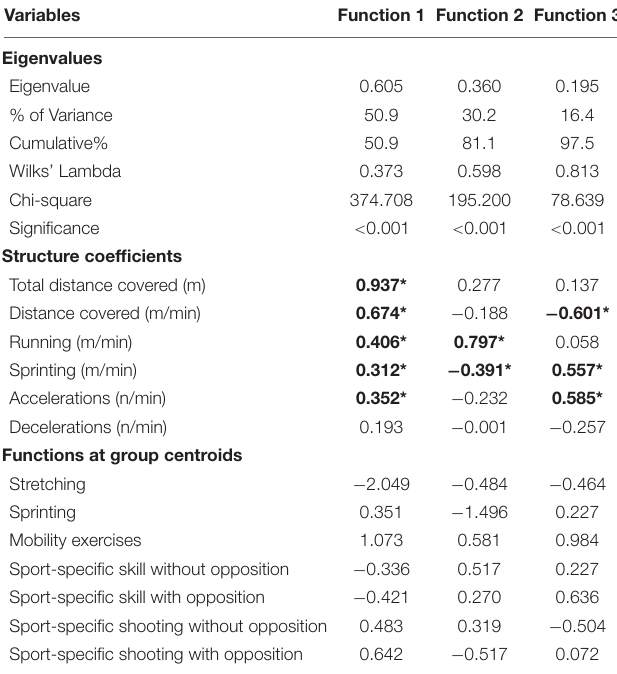
TABLE 5 | Summary of discriminant functions.